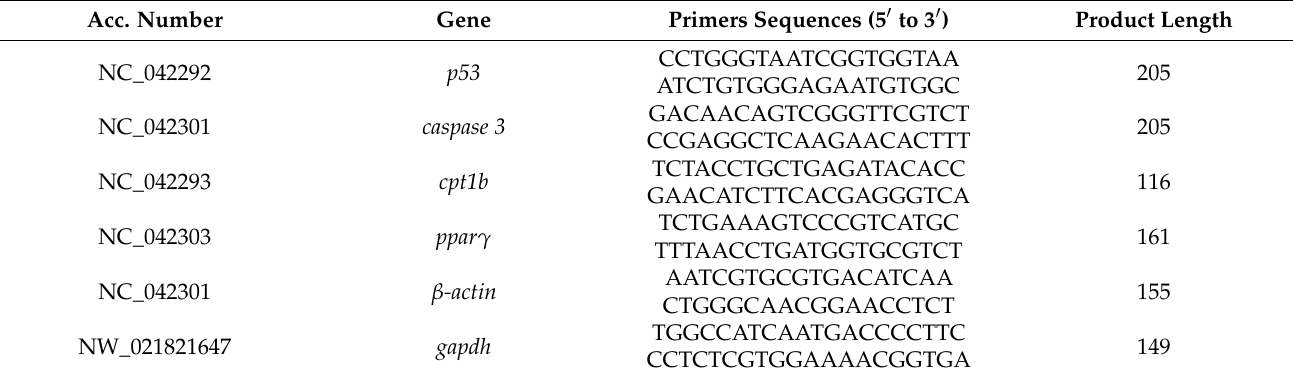
Table 1. Specific primers for the selected and reference